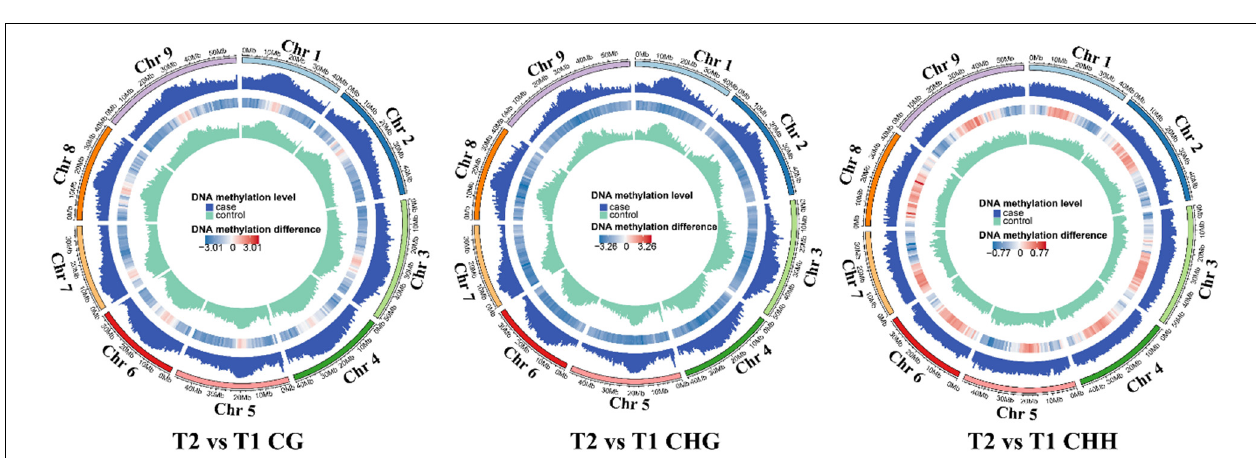
Frontiers in Plant Science |